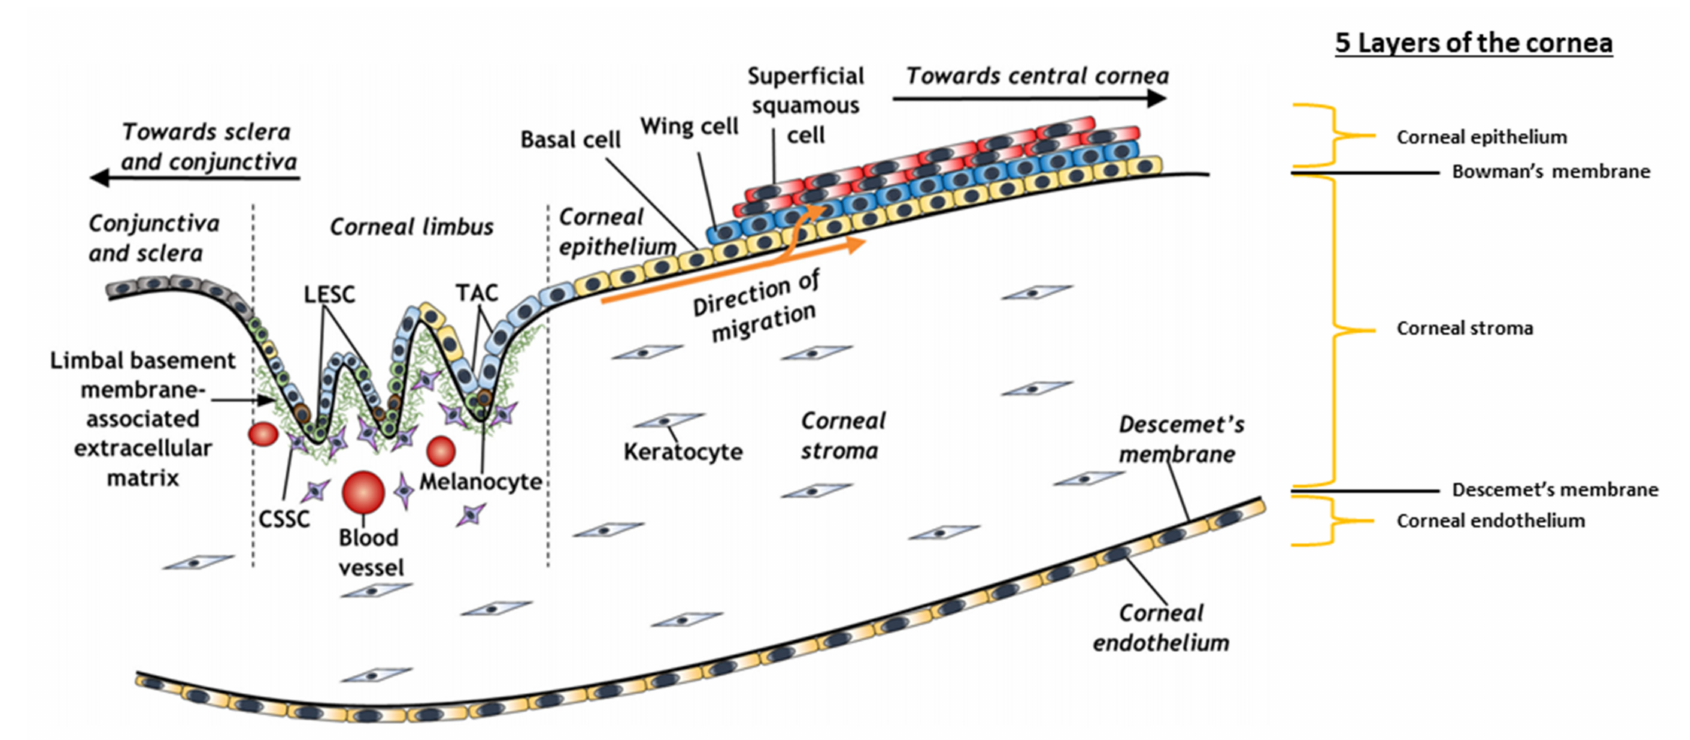
Figure 3. Schematic representation of the corneal limbal stem cell niche and some of its constituent elements (LESCs, limbal epithelial stem cells; CSSCs, corneal stromal stem cells; TAC, transient amplifying cells). Reproduced and adapted with permission of Ashworth et al. (2021)